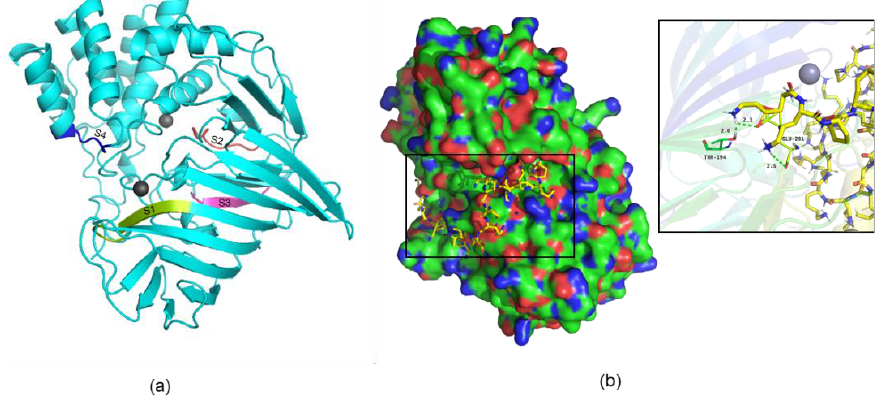
Figure 5. Homology modeling and substrate docking of pldII. ( a ) Homology structural model of pldII. The sites repressed in this study are marked in different colors; ( b ) pldII with a docked ε -PL. The diagram on the right shows the docking diagram with the active